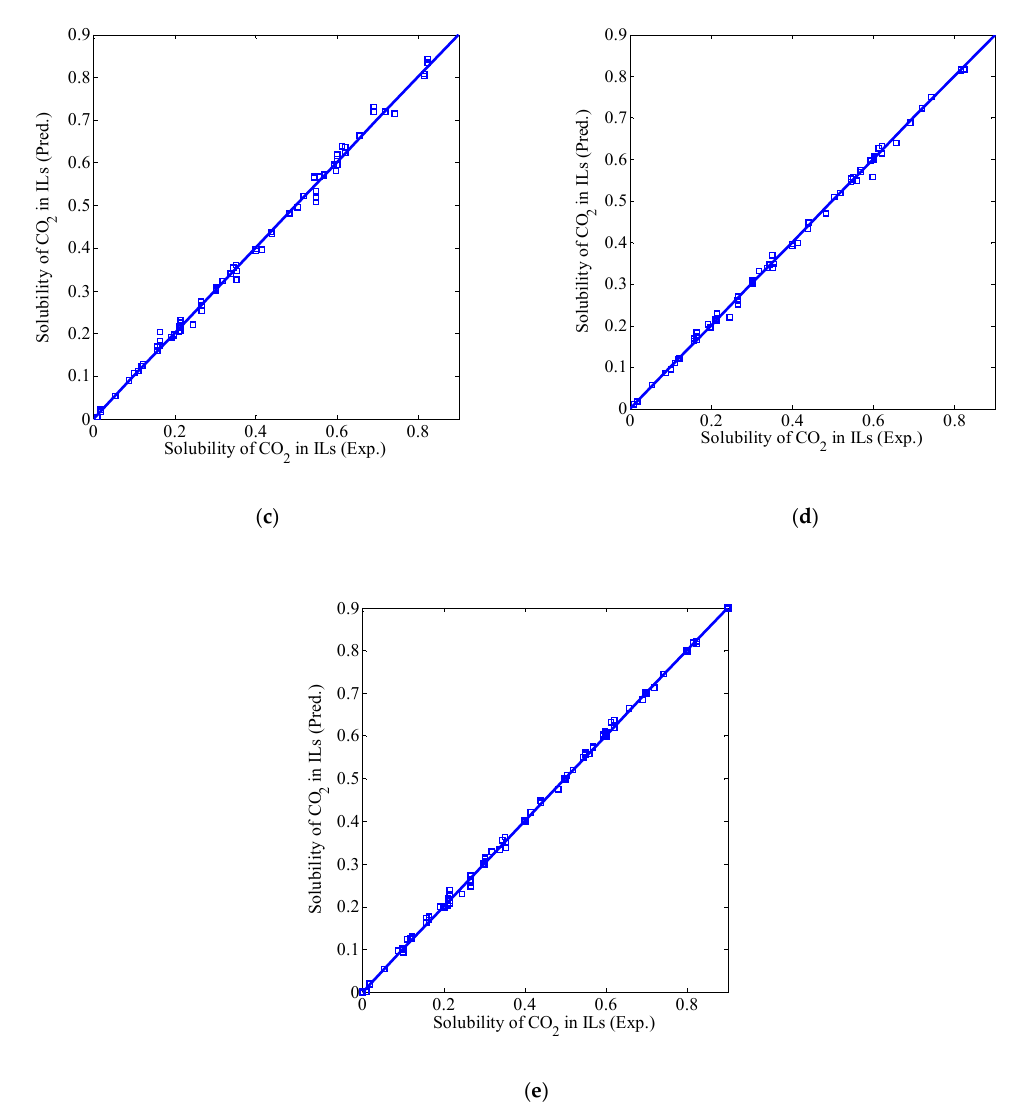
Figure 4. Experimental data versus models results: ( a ) BP, ( b ) SVM, ( c ) ELM, ( d ) linear fusion model I, and ( e ) linear fusion model II.